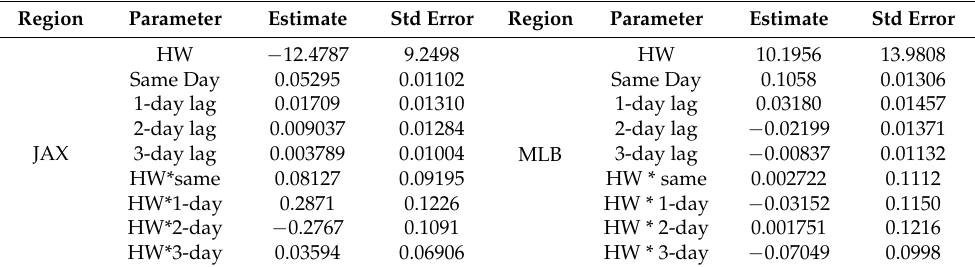
Table 6. Truncated Poisson model results (JAX) and truncated negative binomial results (MLB), using the spatio-temporally imputed data for MLB and JAX region a,b